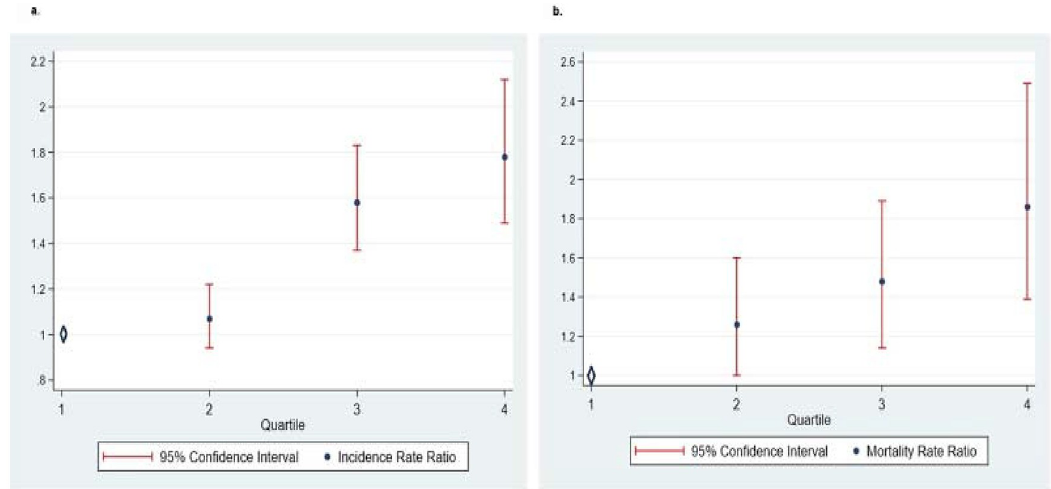
Fig 1. Relative risk increase in incidence and mortality of Covid-19 with each quartile of percentage of households with poor housing conditions.